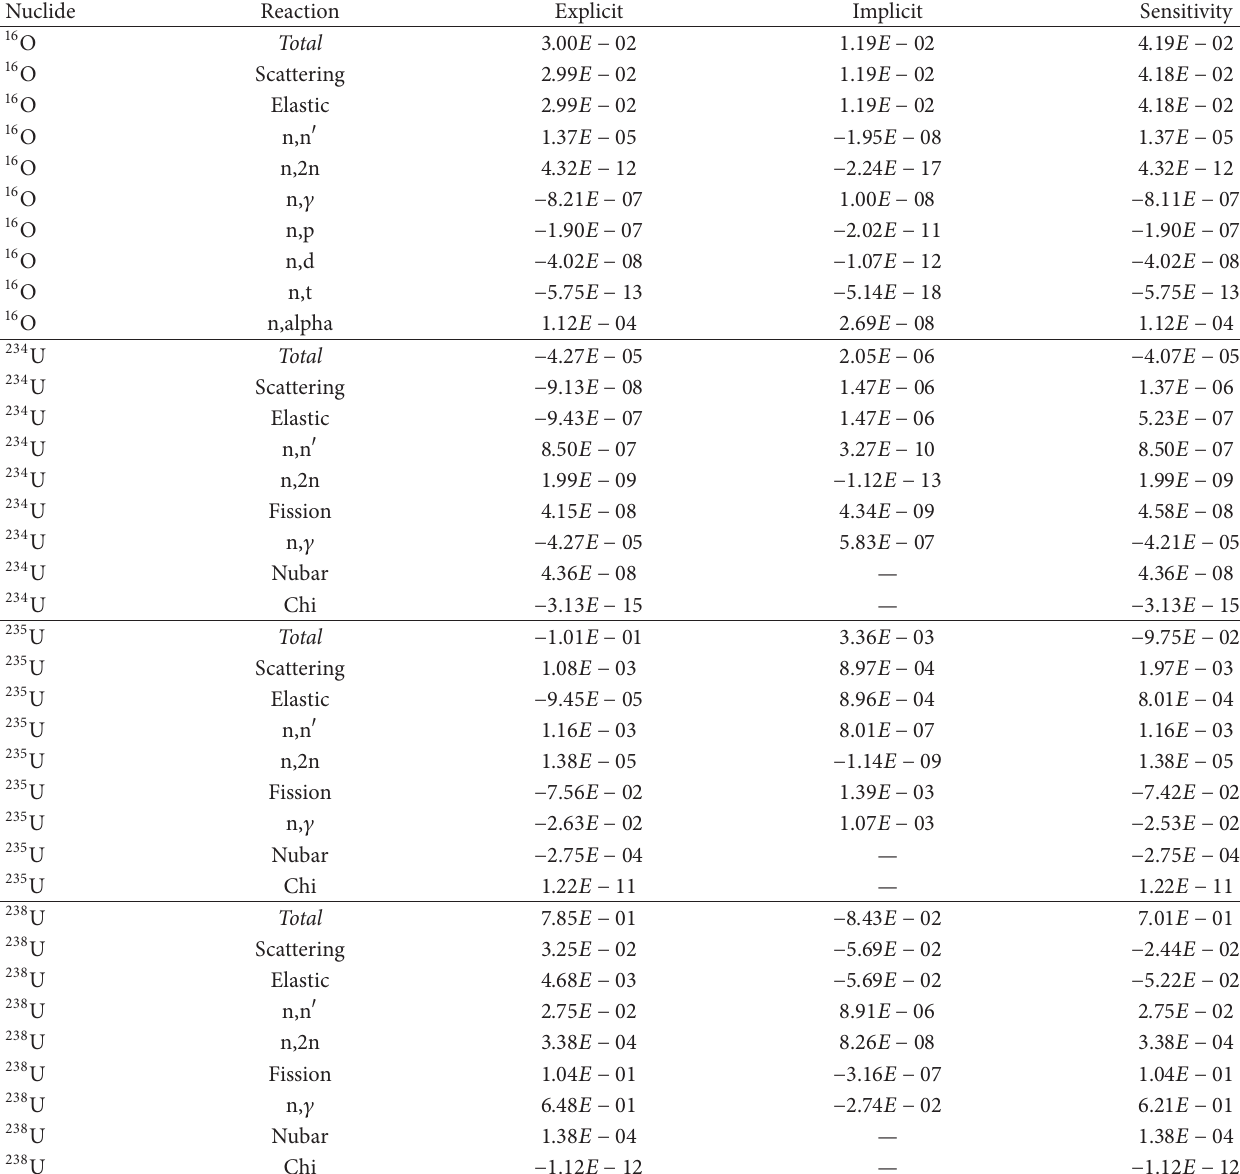
Table 3: Exercise I-1: PWR test case at HFP: energy integrated sensitivity coefficients of the 238 U absorption cross-section with respect to different cross-section